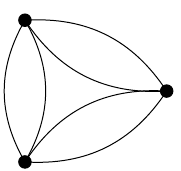
Figure 11 . Feynman graph contributing to the free energy at order 3 in the coupling constant. The vertices are either two tetrahedron and one g